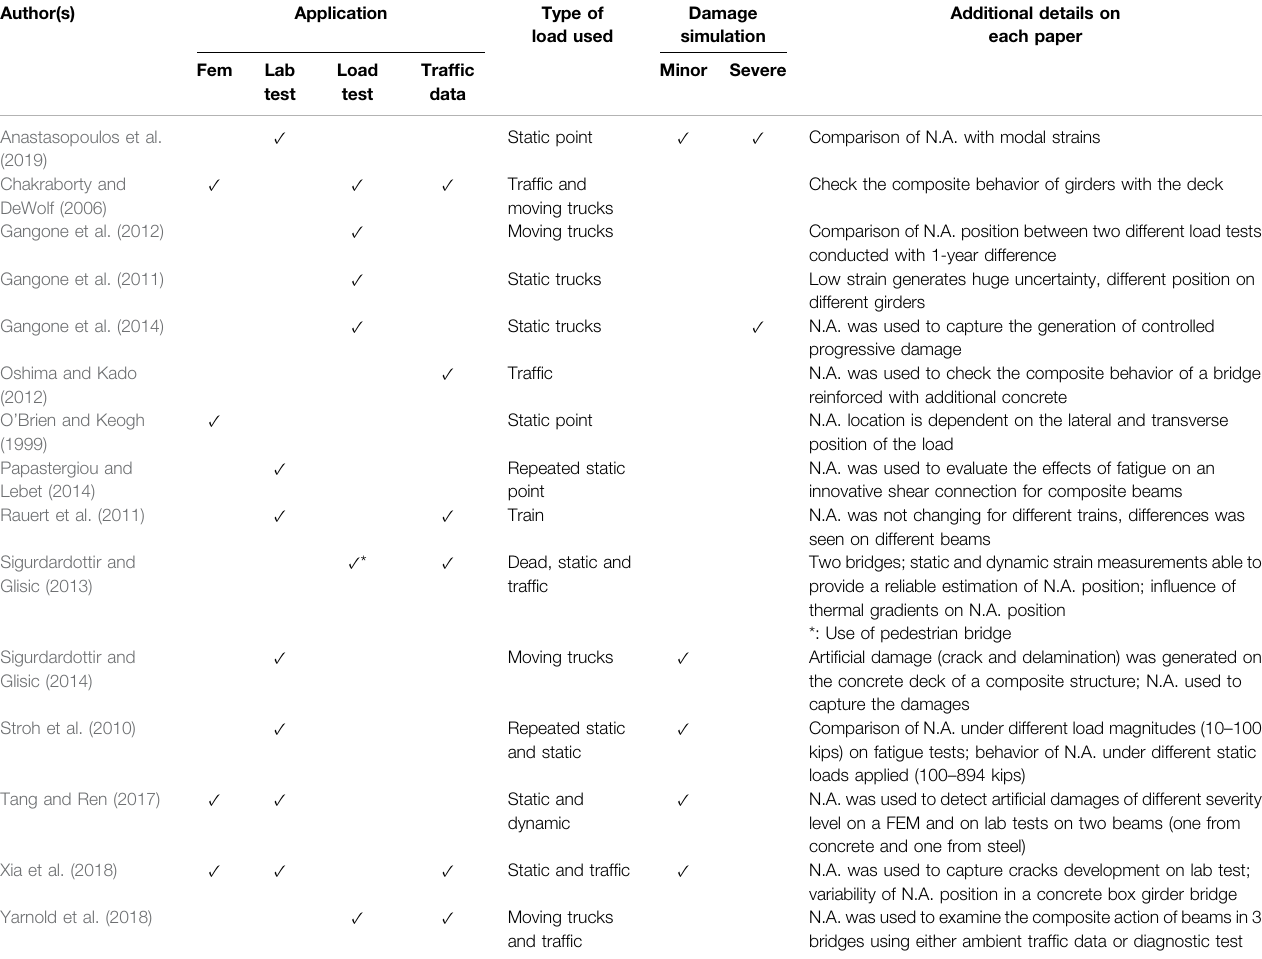
TABLE 1 | Characteristics of literature